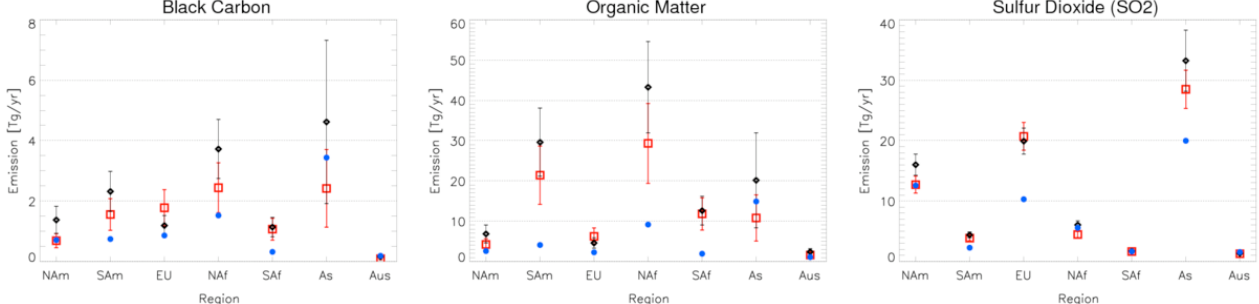
Figure 10. Fig. 10. Same as Fig. 9 but for black carbon, organic matter and sulphur dioxide for North America (NAm), South America (SAm), Europe (EU), North Africa (NAf), South Africa (SAf), Asia (As) and Australia (Aus). Emission fluxes of the first guess (FG, red) and analysis